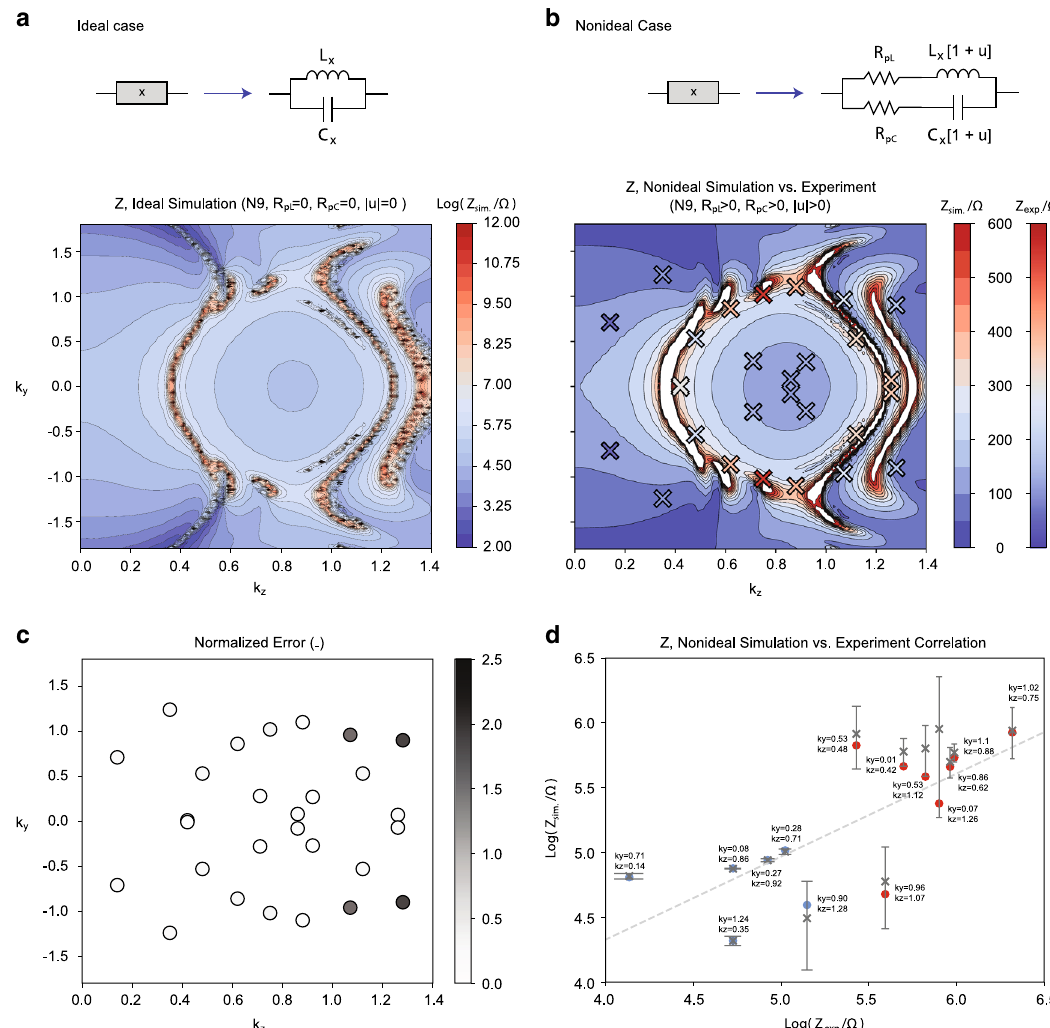
Fig. 7 Experimental vs. simulations with ideal/nonideal components. a Simulated impedance map for N = 9 with ideal components speci fi ed by Supplementary Table 1 with no parasitic resistance or uncertainty, with an elevated drumhead region clearly visible. White regions denote impedance values above 600 Ω . b Contour plot of simulated impedance map for the same scenario as in ( a ), but with parasitic resistance R p L = 0.11 Ω , R p C = 0.03 Ω and random variation in inductor and capacitor values u ∈ [ − 0.01, 0.01], Z sim. , and Experimentally measured impedance Z exp : (colored crosses), see Supplementary Table 3. b Normalized error of measured points, NormalizedError ¼ ðj Z exp : (cid:1) Z sim : j = Z sim : Þ 2 . c Plot of the Log of expected simulated impedance, Log( Z sim. ), vs. the Log of experimentally measured impedance, Log ð Z exp : Þ (blue and red dots). The blue dots represent points in the low-lying regions, while the red dots are located near the drumhead region. The gray dashed line is the line computed by least squares regression. Gray crosses represent the mean of the simulated impedance within a 0.03 radius in k space surrounding a particular k y , k z point, while error bars represent the standard deviation of impedance within the 0.03 k radius of that particular k y , k z point, which is shown in Supplementary Tables 4 – 14. For k y , k z points in regions with very high local standard deviation, the gray cross may not coincide with the blue/red dots. The correlation coef fi cient between Log( Z sim ) and Log ð Z exp : Þ is 0.743, and increases to 0.863 when the three borderline points with largest variance are